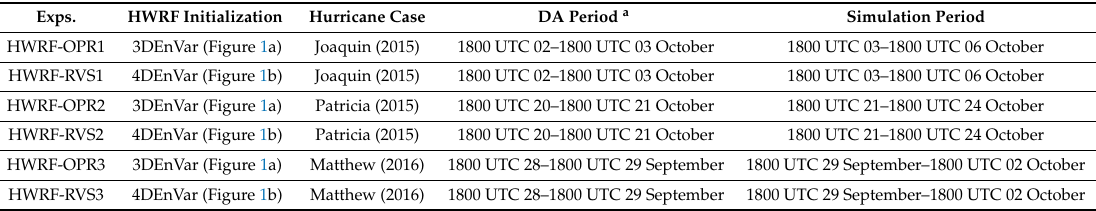
Table 2. List of